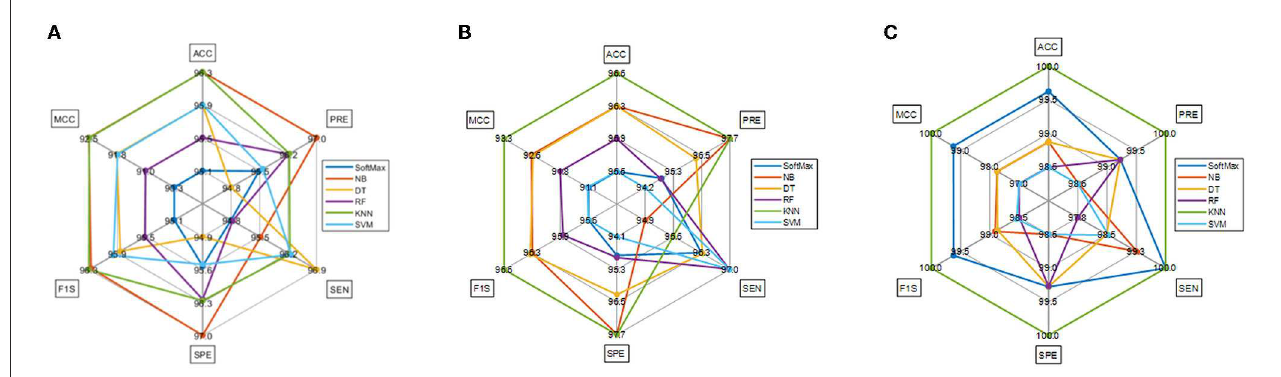
FIGURE8 Spider plot achieved using the results of Table 6. (A) VGG19. (B) DenseNet121. (C) Fused deep features (VGG